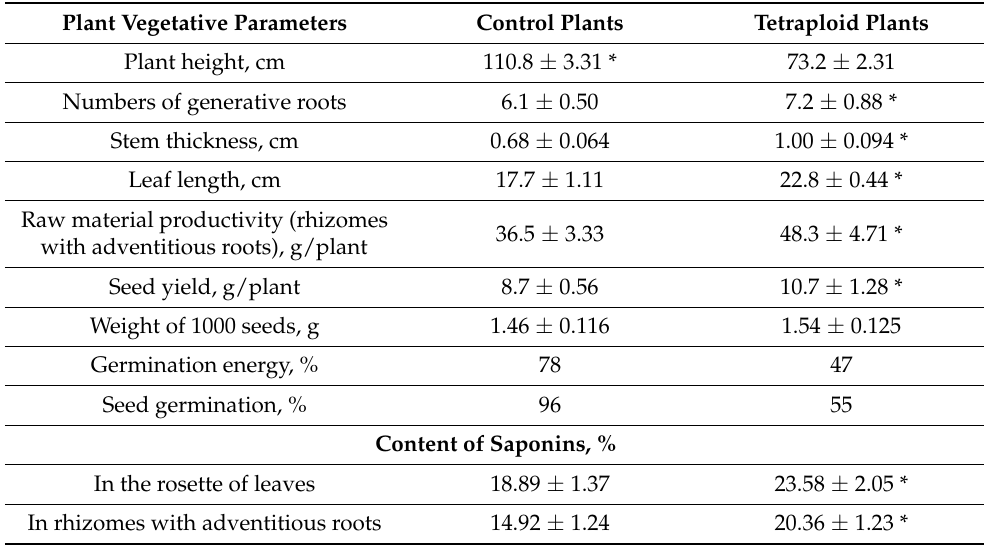
Figure 2. Flowering control diploid ( a ) and colchicine-induced tetraploid ( b ) plants of Polemonium caeruleum.